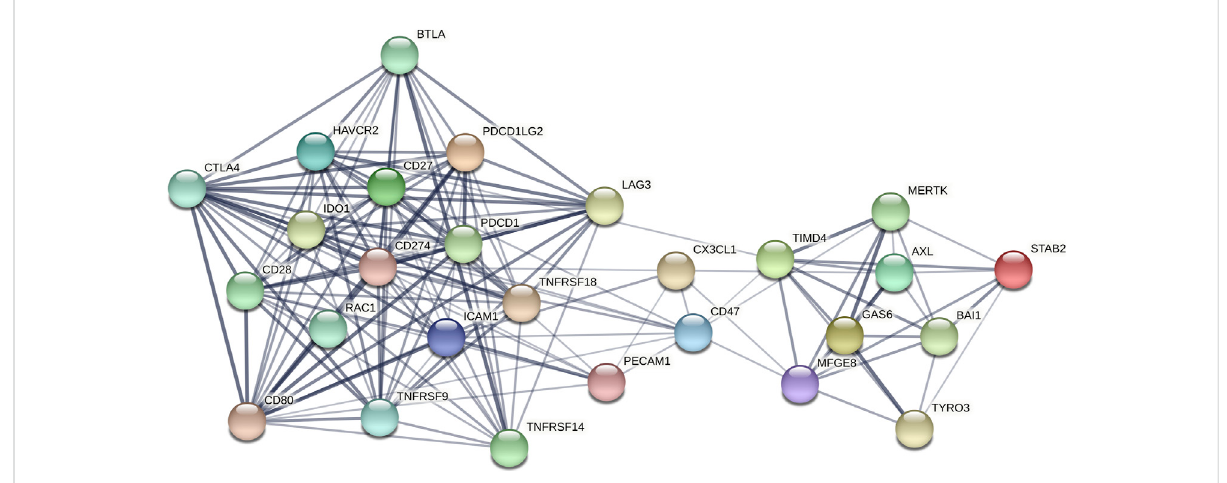
FIGURE 1 The PPI network of the 15 efferocytosis-related molecules and 12 other immune checkpoint-related molecules with con fi dence > 0.4. The thickness of the line indicates the size of the correlation coef fi